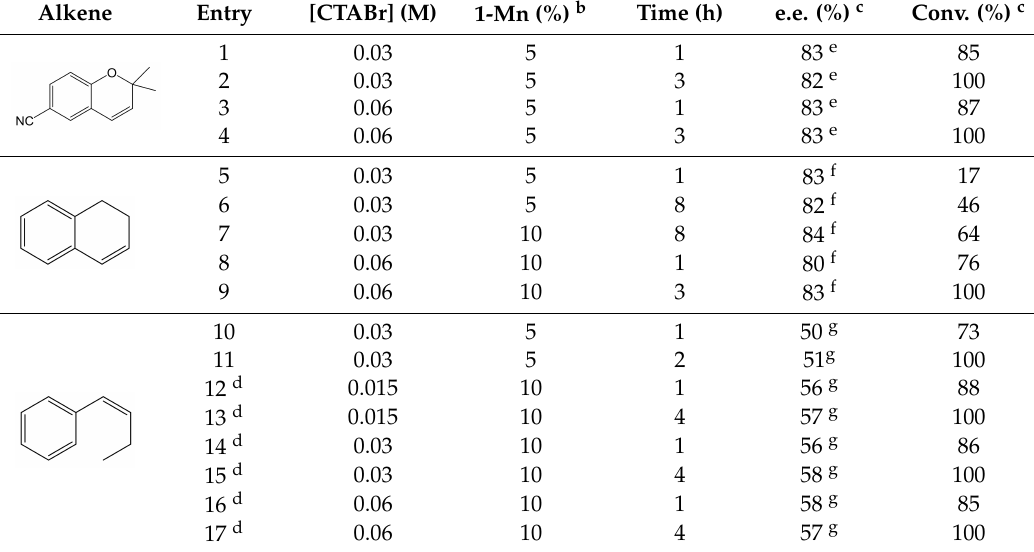
Table 1. Enantioselective epoxidation of 6-CN-2,2-dimethylchromene, 1,2-dihydronaphthalene, and cis - β -ethylstyrene with NaClO catalyzed by micellar nanoreactor containing 1-Mn and CTABr in H 2 O at 25 ◦ C a